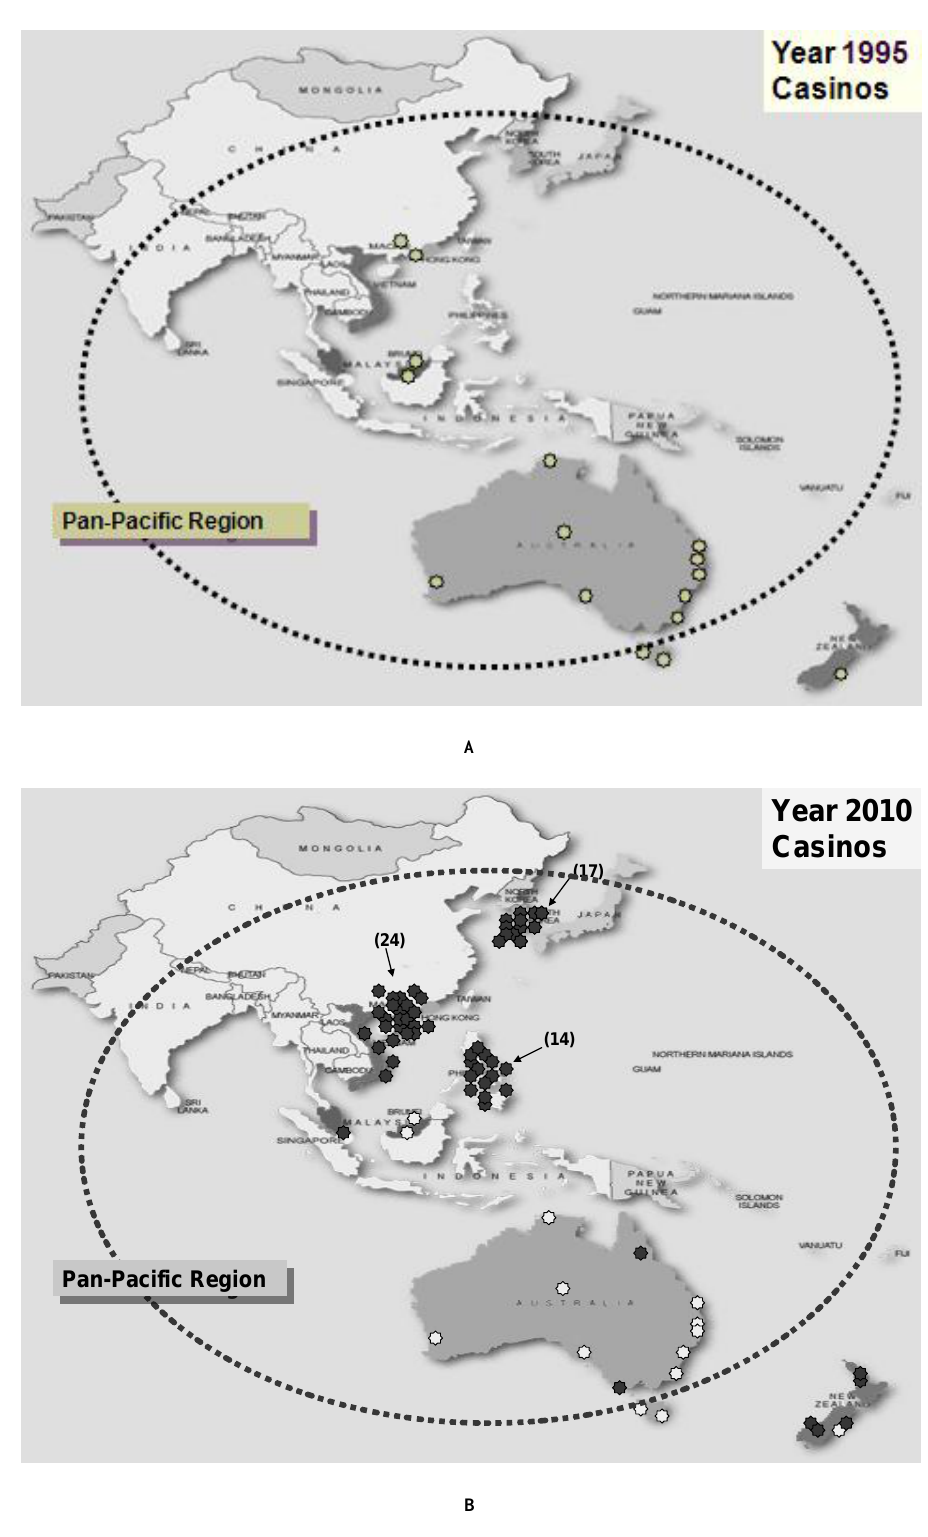
FIGURE 1. (A) Grey dots denote the number and location of the casinos in 1995 in the Pan-Pacific region; (B) black dots denote the number and location of additional casinos in the year 2010 in the Pan-Pacific